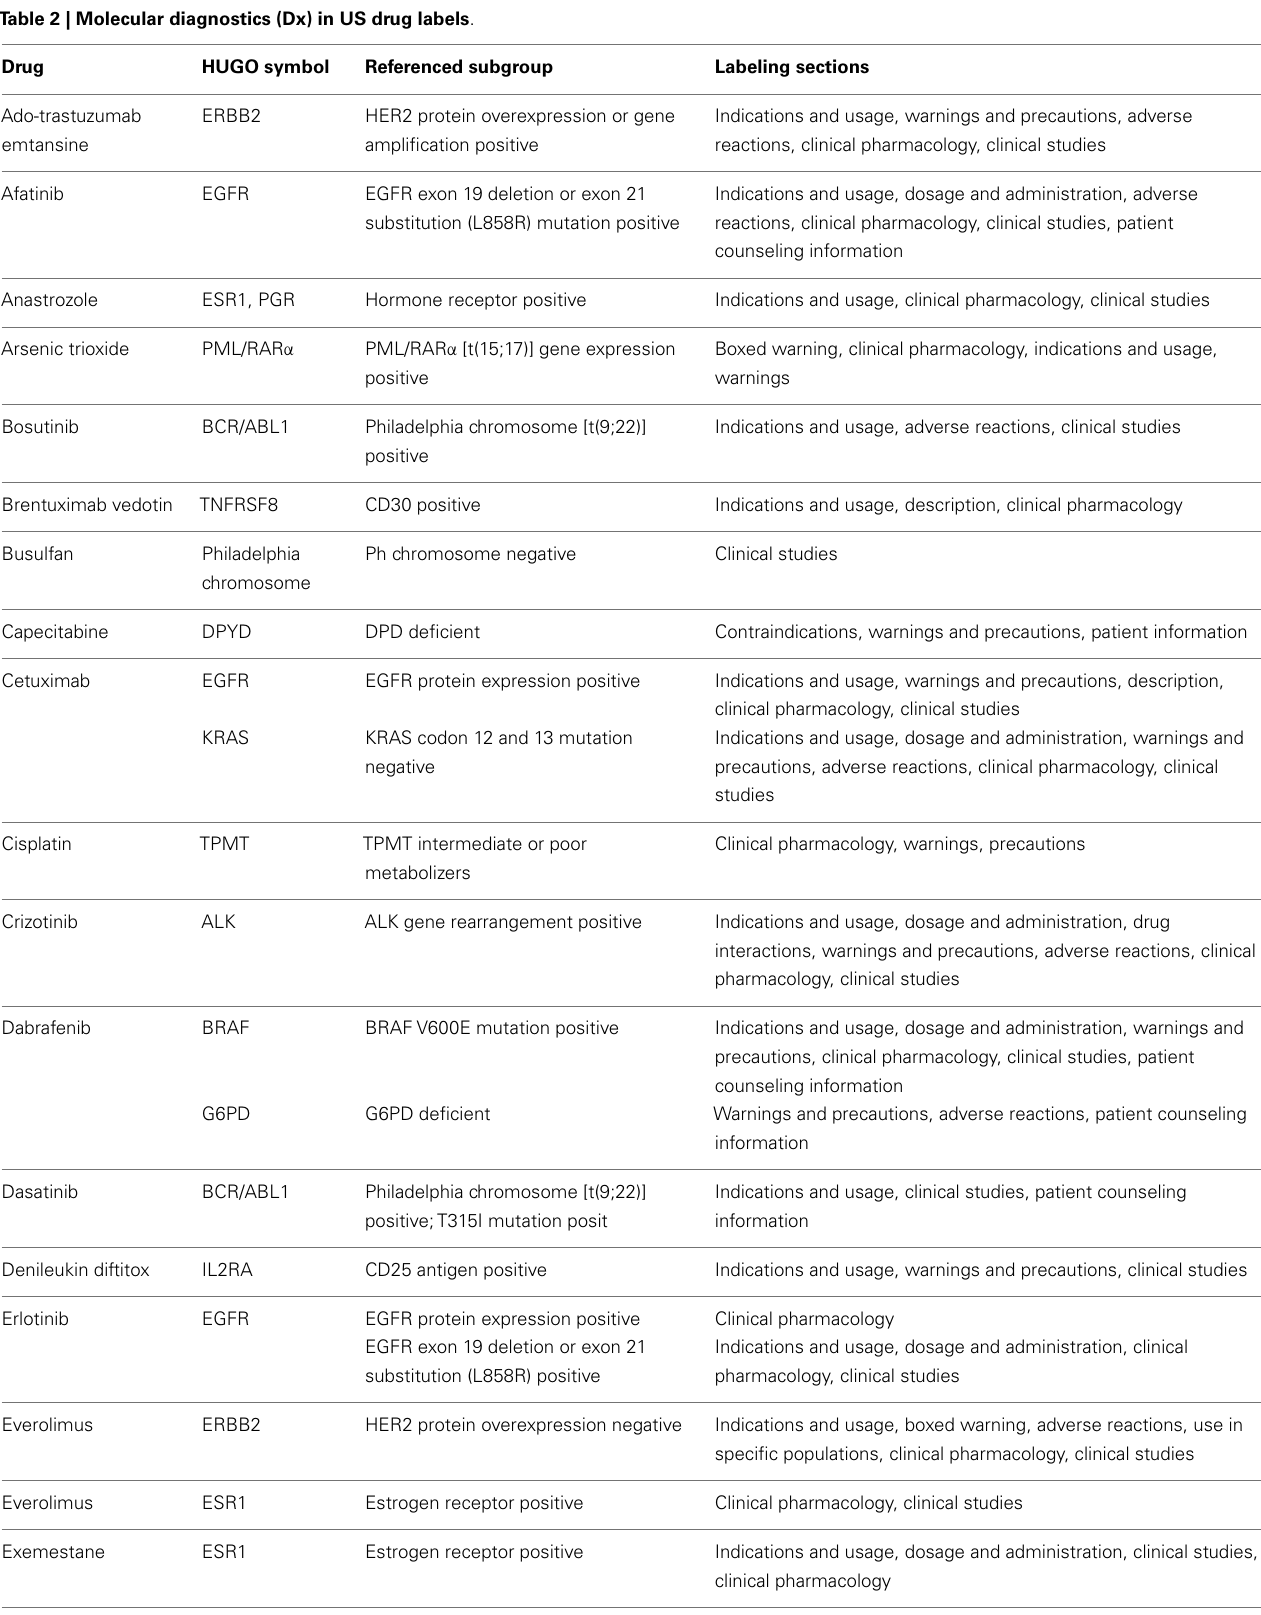
Table 2 | Molecular diagnostics (Dx) in US drug labels